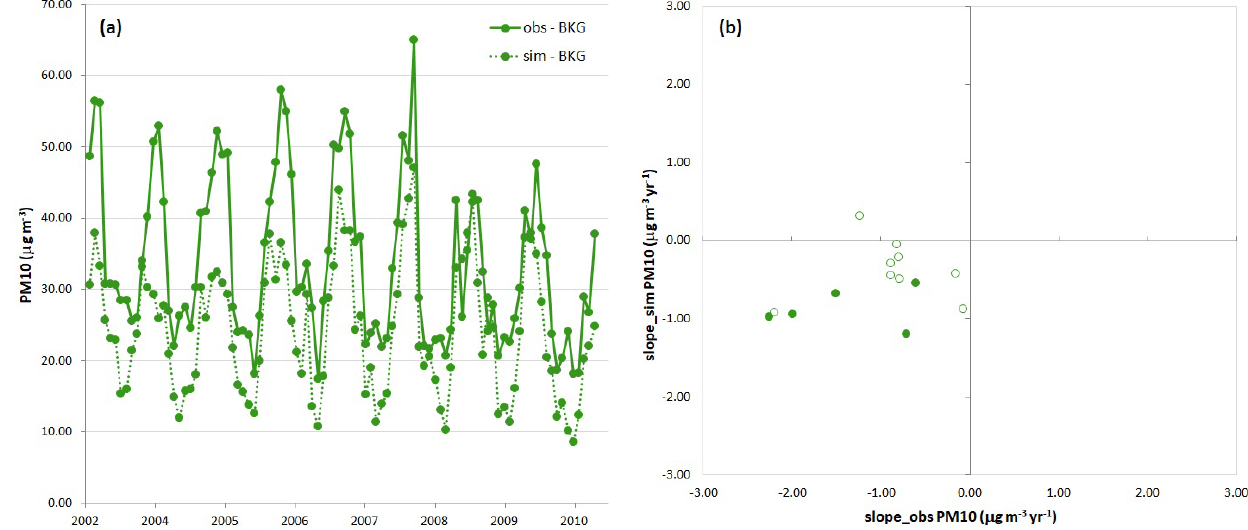
Figure 8. (a) Observed (solid line) and simulated (dashed line) monthly means of PM 10 concentrations (in µgm − 3 ) for all the background monitoring stations. (b) Scatter plot of observed and simulated slopes (in µgm − 3 yr − 1 ) at each individual station. Sites where significant slopes are estimated for both observations and simulated data are indicated with a filled symbol.